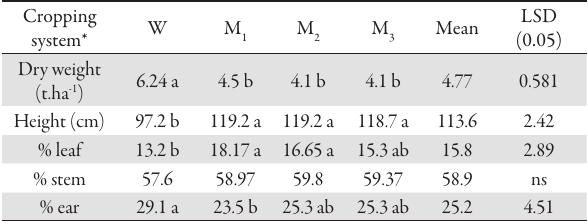
Tab. 3. Effect of different cropping system on crops dry weight (t. ha -1 ) and dry weight of weed (kg.ha -1 )